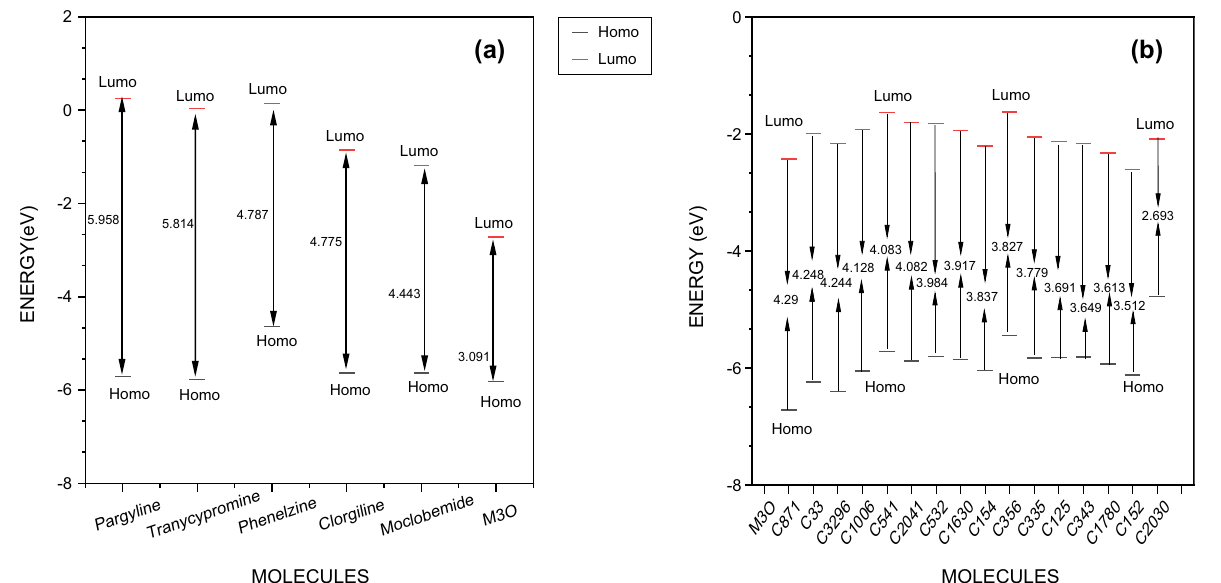
Fig. 4 Molecular orbital diagram, HOMO–LUMO energy change (ΔE); a Commercial drugs; and b Chalcone